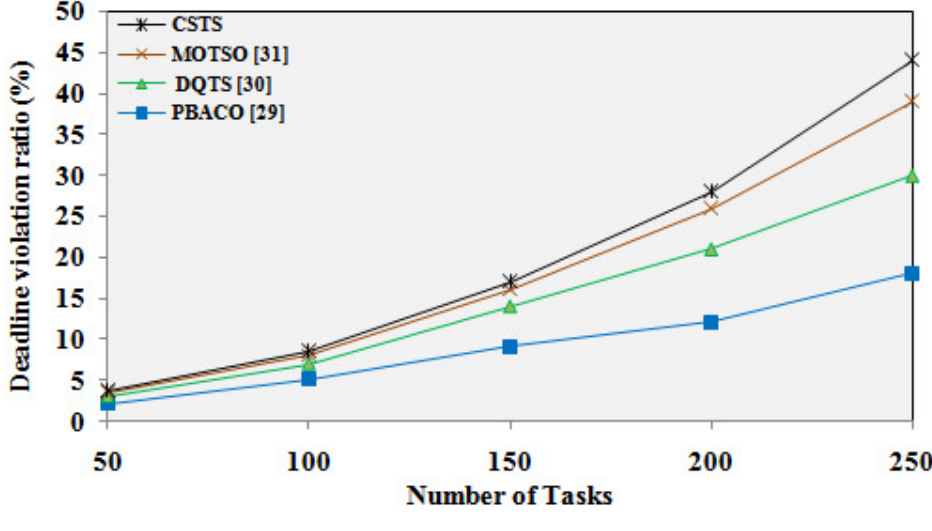
Figure 4. Deadline violation rate with number of task.